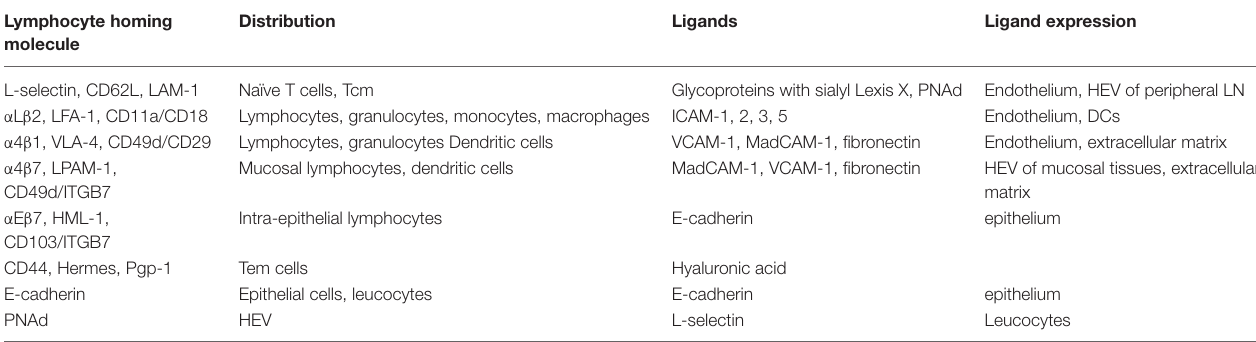
TABLE 1 | Homing determinants: integrins/ligands, vascular addressins and receptors. Lymphocyte homing